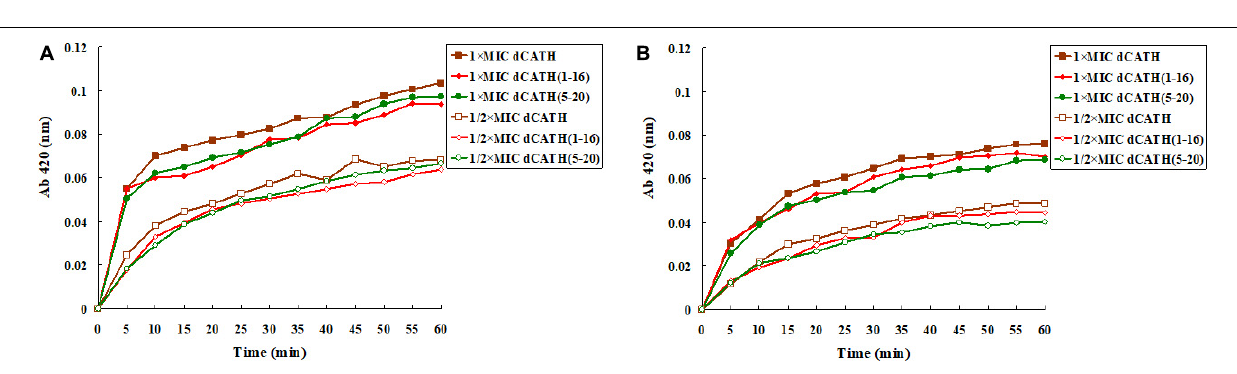
FIGURE 3 | Cytoplasmic membrane variation of E. coli ATCC 25922 and S. aureus ATCC 29213 treated by peptides. ONPG was cleaved by cytoplasmic β -galactosidase of E. coli ATCC 25922 and S. aureus ATCC 29213 treated by 1 × MIC of dCATH, 1 × MIC of dCATH (1–16), 1 × MIC of dCATH (5–20), 1/2 × MIC of dCATH, 1/2 × MIC of dCATH (1–16), 1/2 × MIC of dCATH (5–20), respectively. Hydrolyzate (ONP) was measured spectroscopically at absorbance of 420 nm as a function of time. (A) E. coli ATCC 25922, (B) S. aureus ATCC